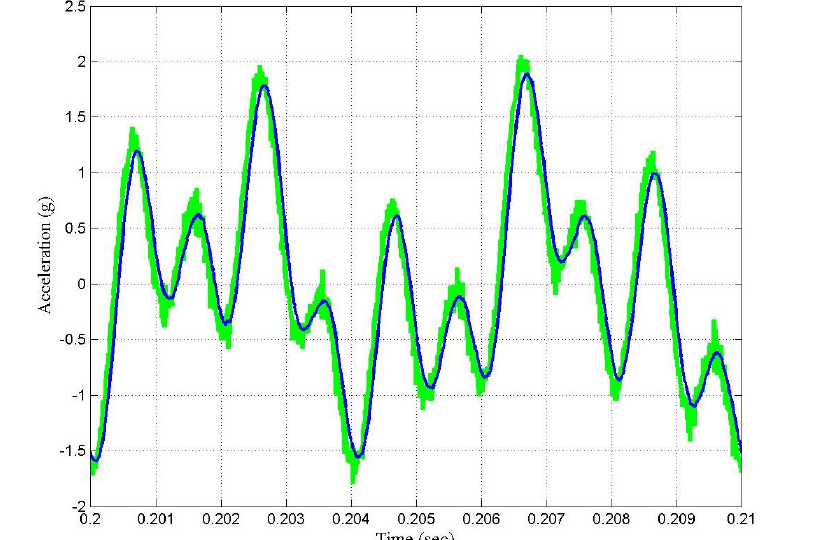
Figure 8. Time waveforms of the output signal for the case under test: Green—output signal before filtering; Blue—output signal after filtering by using the LMS adaptive